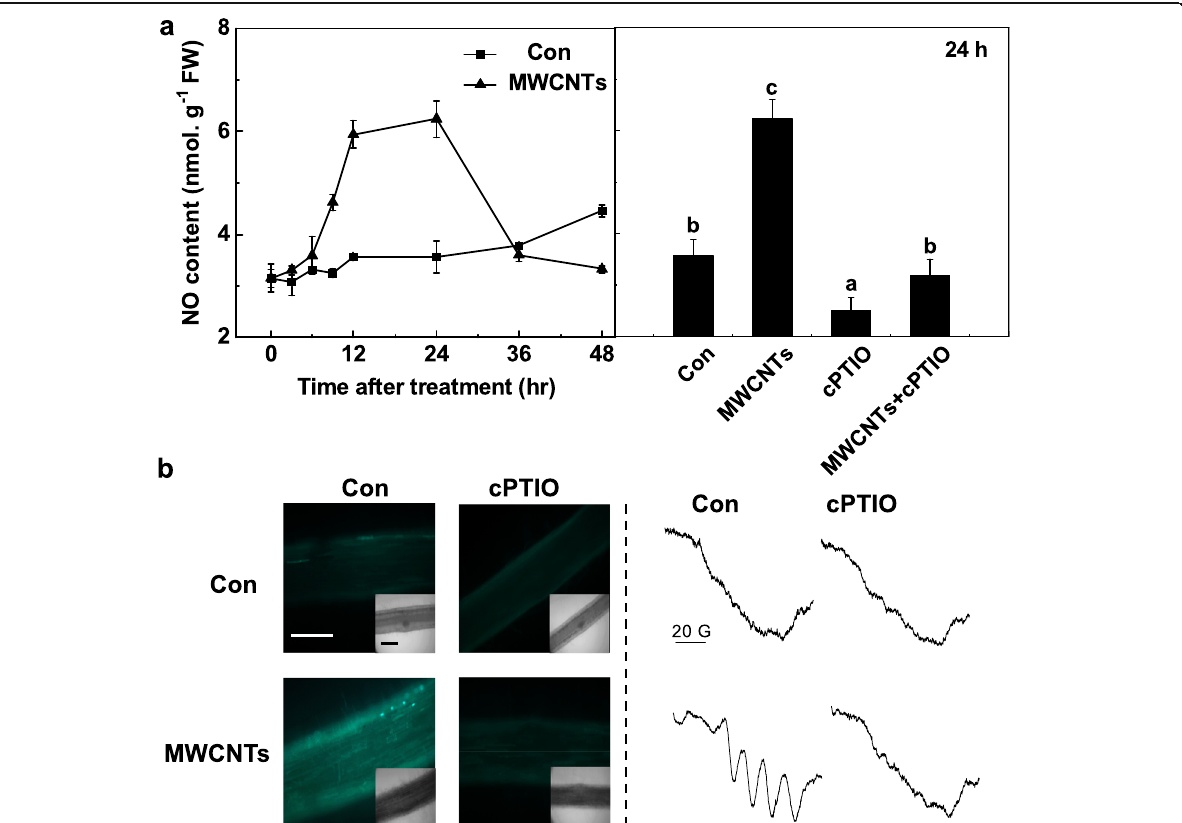
Fig. 5 MWCNT-induced NO production was blocked by cPTIO, the scavenger of NO. Three-day-old tomato seedlings were treated with distilled water and 5 mg/mL MWCNTs with or without 0.2 mM cPTIO, respectively. a Changes in NR activity (left), and NO production (right) determined using Greiss reagent method. b After treamtent for 24 h, the NO signal was analyzed by LSCM (left) and EPR (right). Scale bar = 0.1 mm. Data are the means± SE. Bars denoted by the same letter did not differ significantly at p < 0.05 level according to Ducan ’ s multiple